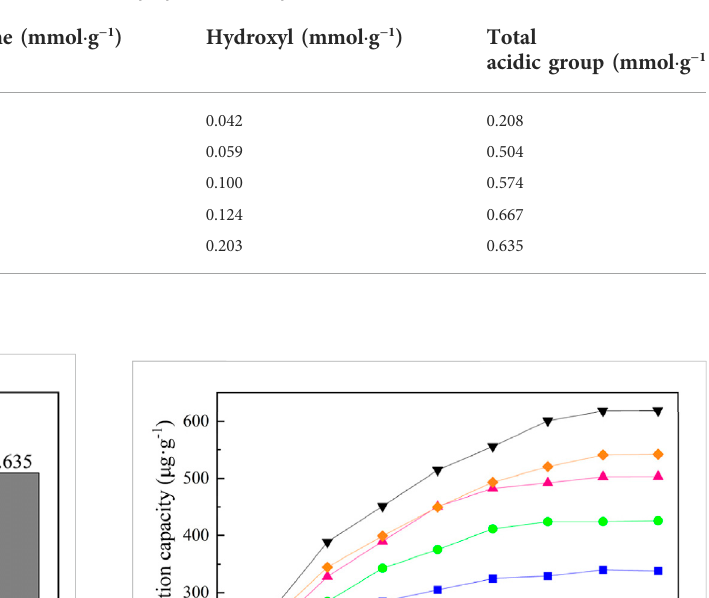
TABLE 2 Quantitative characterization of the surface compositions of the as-prepared AC samples.